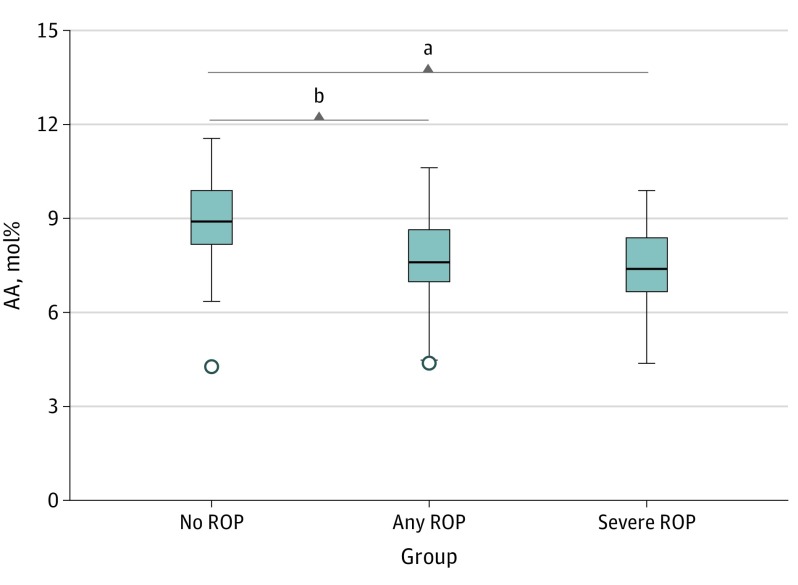
Differences in Serum Fractions of Arachidonic Acid (AA) at 32 Weeks’
Postmenstrual AgeShown are the medians (outlier 5% to maximum) for infants with no and any
retinopathy of prematurity (ROP) and median (minimum to maximum) for infants with
severe ROP (ROP stage 3 or T). mol% Indicates percentage of total quantified fatty
acids.aP < .01.bP < .001.